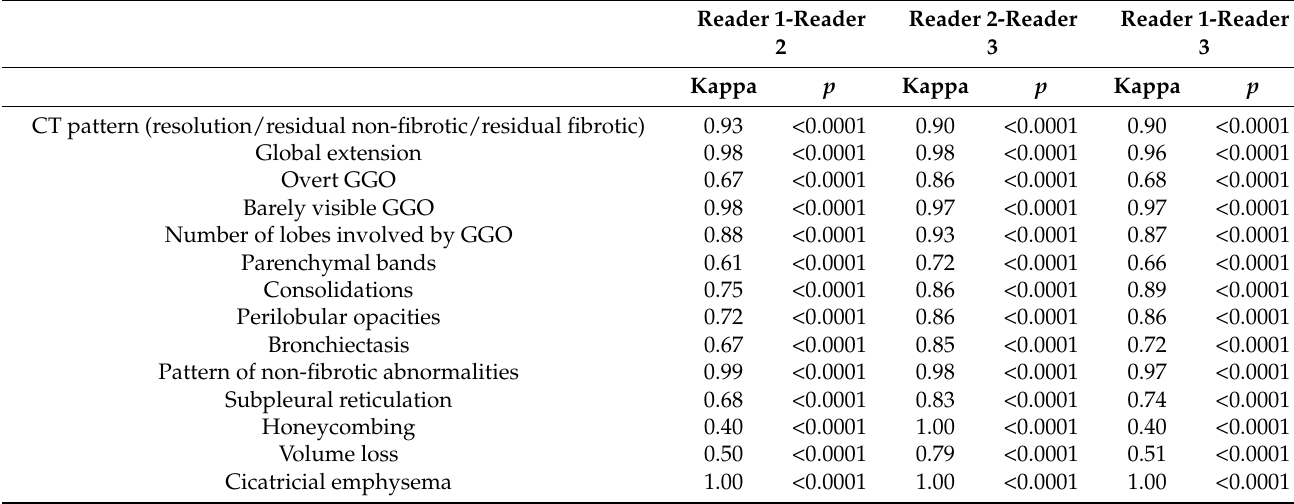
Table A1. Inter-rater agreement.